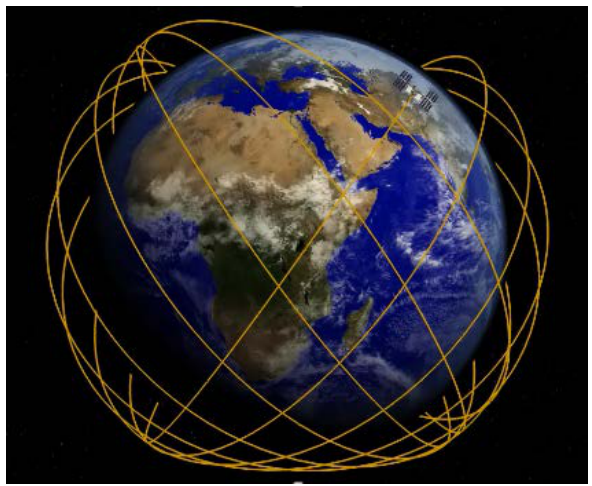
Figure 1. The inclined equatorial orbit of the ISS (ground tracks shown in